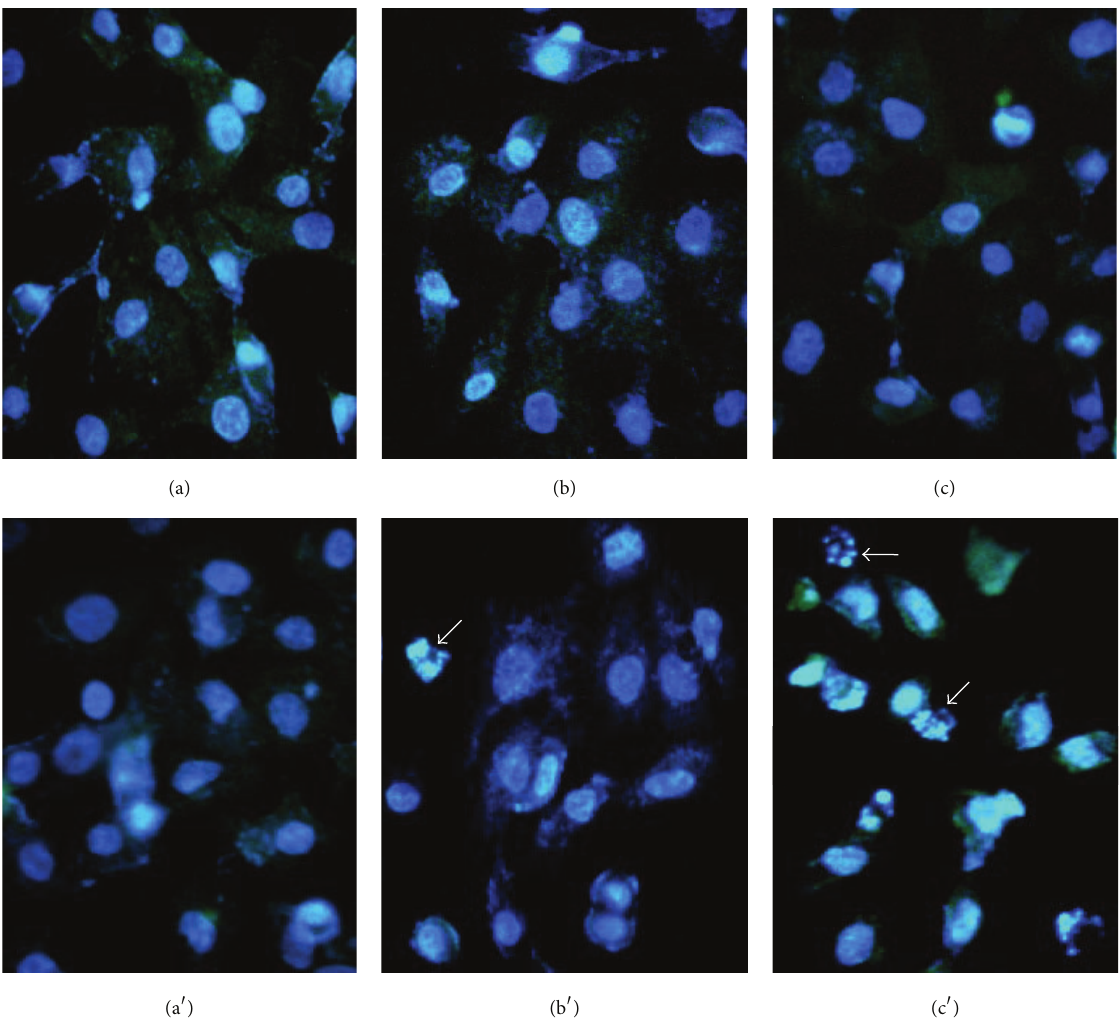
Figure 3: Nuclei of cells exposed to SeMet and SSe: controls (a and a 󸀠 ); cells exposed to 0.5 and 1.5mM Se as SeMet (b, c); cells exposed to 0.5 and 1.5 mM Se as SSe (b 󸀠 , c 󸀠 ) for 48 h. Arrows indicate nuclear fragmentation in SSe-treated